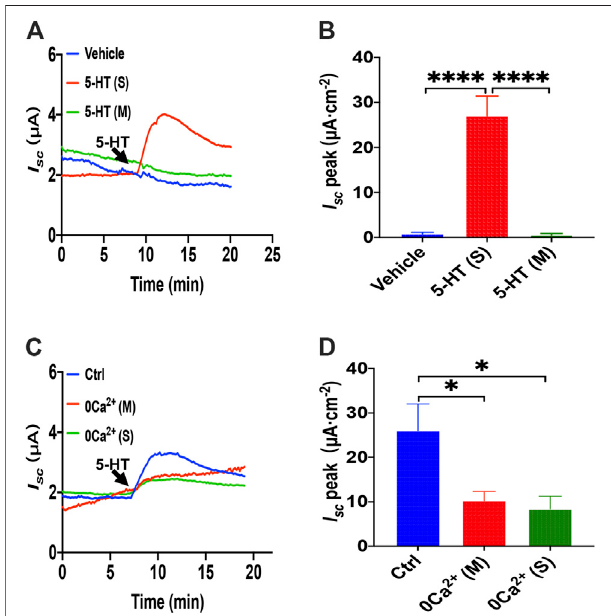
FIGURE 5 | 5-HT induced Ca 2+ -dependent duodenal epithelial ion transports. (A) Time courses of 5-HT (10 μ M) -evoked I sc or vehicle (DMSO) when added to serosal (s) or mucosal side. (B) When added to the serosal or mucosal side, vehicle or 5-HT-evoked I sc peak ( n (cid:2) 6). (C) Time courses of 5-HT-evoked I sc after extracellular Ca 2+ omission (0 Ca 2+ ) from each side in duodenalmucosaltissues. (D) 5-HT-evoked I sc peakafterCa 2+ omissionfrom each side (s or m, n (cid:2) 6). Ctrl represents as the control in which normal extracellular Ca 2+ was on both sides. Results are presented mean ± SE. * p < 0.05, **** p < 0.0001 signi fi cantly different from the corresponding control by one-way ANOVA followed by Dunnett ’ s